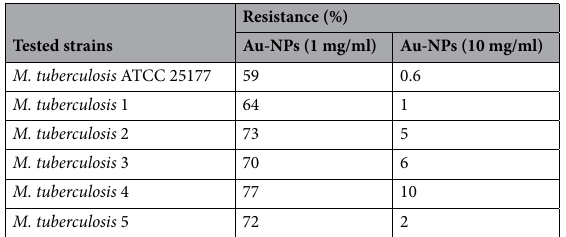
Table 4. The TB resistance percentage against the prepared ultra-small Au-NPs.